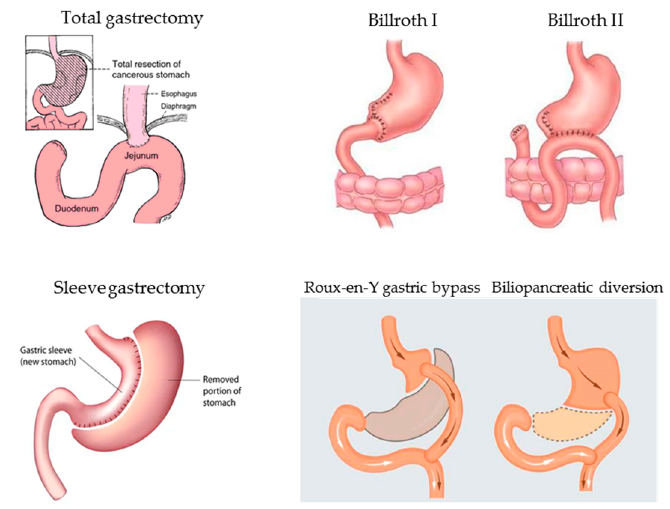
Figure 2. Main gastric surgical procedures potentially leading over time to micronutrient deficiencies due to resection or exclusion of functionally active gastric mucosa necessary for gastric acid and intrinsic factor secretion, in turn, essential for correct micronutrient absorption.